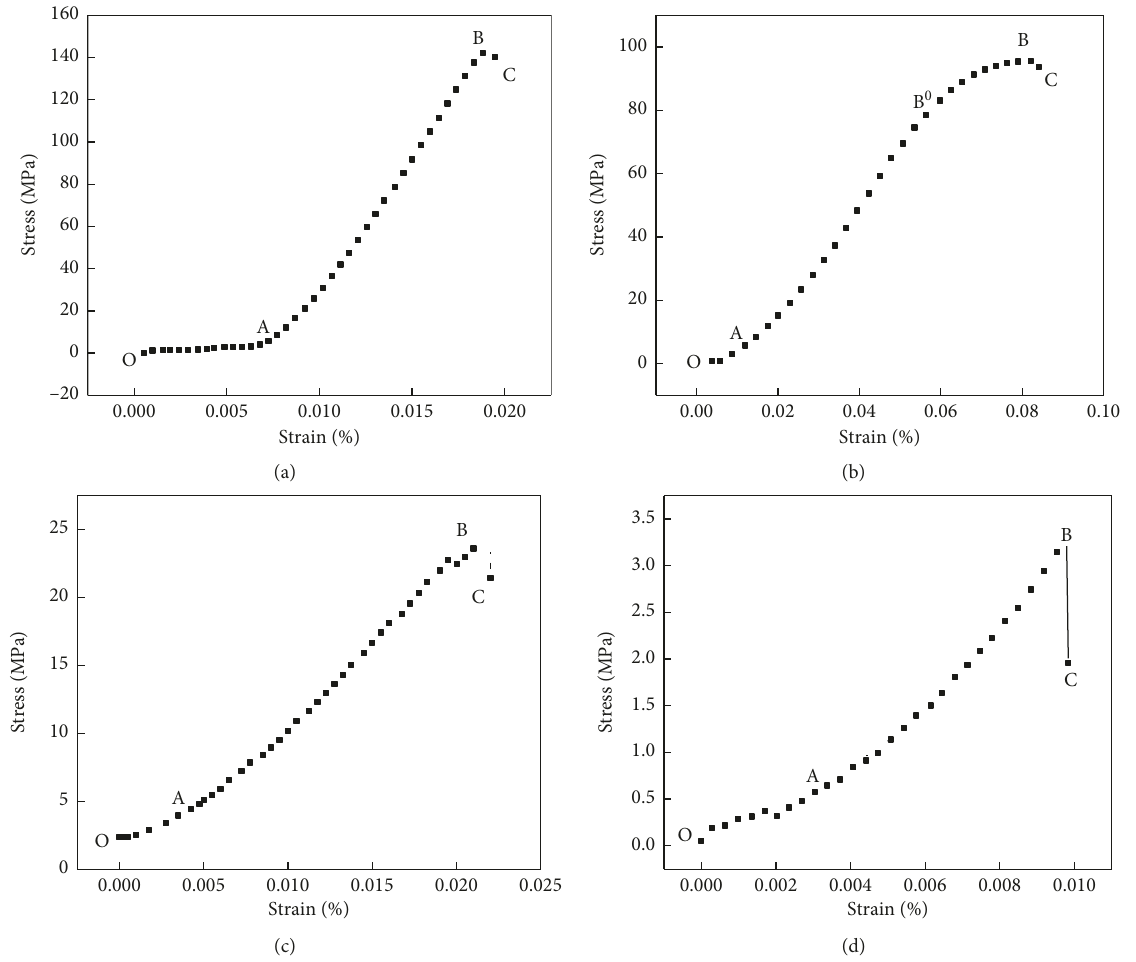
Figure 9: Stress-strain curves of sandstone and transparent rock specimens in the UCS test. (a) Sandstone specimen. (b) Transparent rock specimen without RSS. (c) Transparent rock specimen with 2% RSS. (d) Transparent rock specimen with 10%